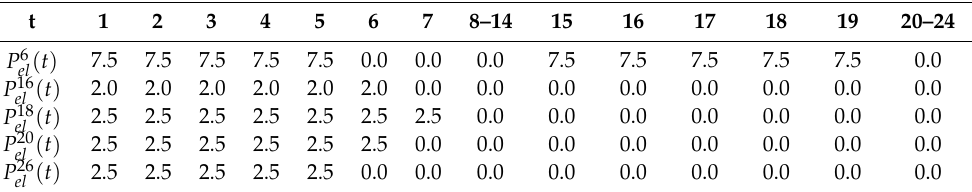
Table 6. Expected values of optimal demand response (MW) in a day.